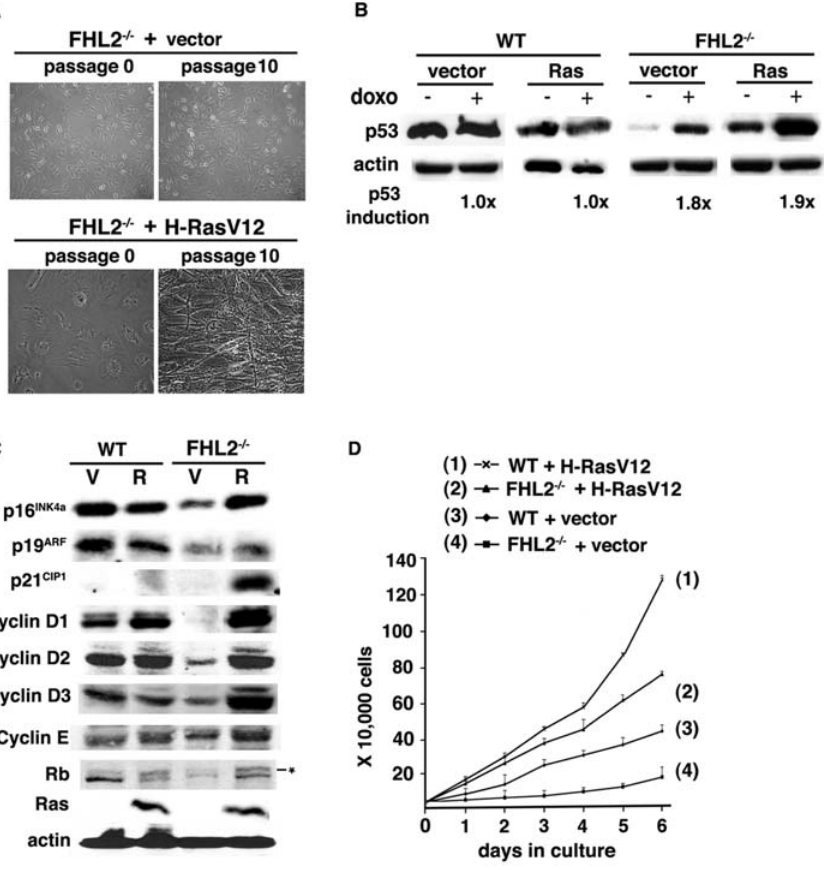
Figure 5. Reversal of the cell cycle arrest in H-RasV12-transduced FHL2 2 / 2 MEFs. (A) The indicated cell lines transduced by H-RasV12 or control vector are shown at cell cycle arrest stage (passage 0) and after reversal of the cell cycle arrest (passage 10). (B) Analysis of the p53 protein in cells at passage 10 after H-RasV12 transduction. Cells were treated with doxorubicine as described in Fig. 3A. (C) Western blot analysis of cell cycle regulators in wt and FHL2 2 / 2 cell lines at passage 10 after transduction with H-RasV12 (R) or empty vector (V). (D) Growth curves of the indicated cell lines after reversal. Equal numbers of cells were initially plated in triplicate wells, and cells were counted at indicated times. Mean values 6 standard deviation from three independent experiments are shown. Data presented are representative of 3 independent H-RasV12- and vector-expressing MEF lines. Ectopic expression of cyclin D1 restores the susceptibility of FHL2 2 / 2 cells to transformation by oncogenic Ras